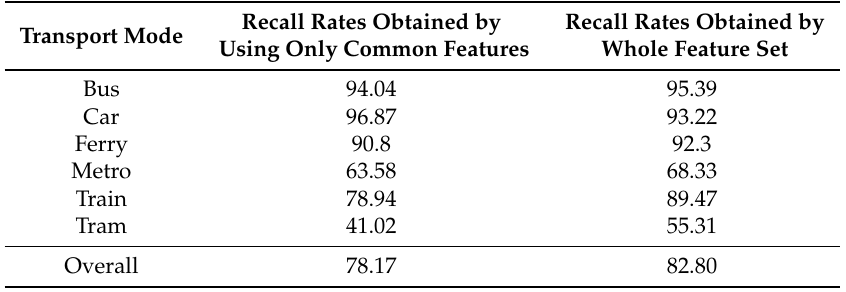
Figure 8. The effect of the overlapping ratio on the classification results. Table 4. Performance of the transport mode detection by using only common time domain features and by using the whole feature set.